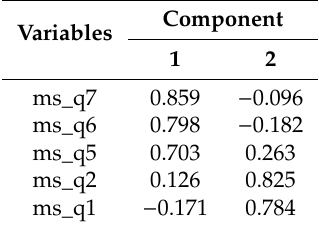
Table 7. Rotated Component